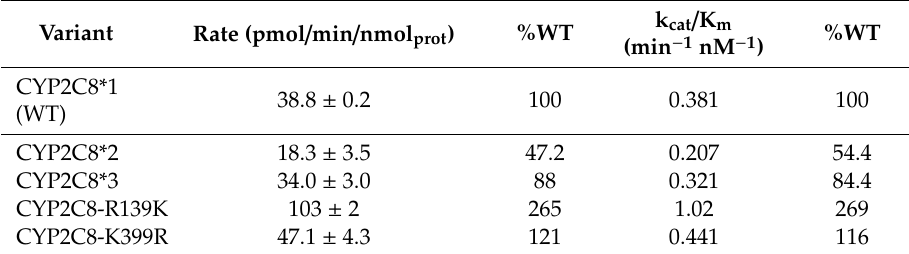
Table 1. Paclitaxel (PAC) metabolism by CYP2C8 variants. Linear rates of 70 µ M PAC metabolism by each CYP2C8 variant to PAC–OH was determined over a 20 min period. Estimates of the catalytic e ffi ciencies were determined using Equation (1) as stated in the text. Error represents the SEM of three